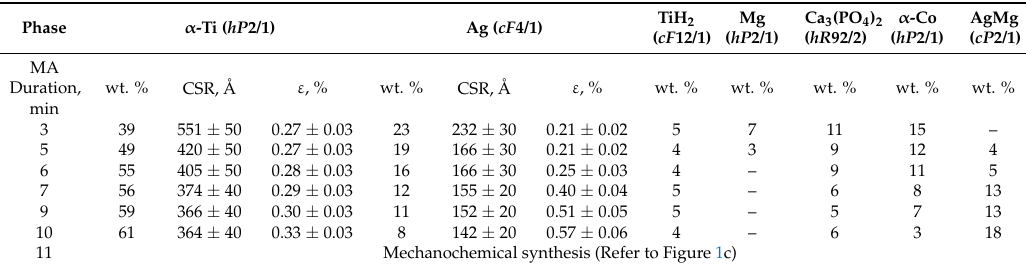
Table 1. Influence of the mechanically activated (MA) duration on the phase composition of the Ti–C–Co–Ca 3 (PO 4 ) 2 –Ag–Mg mixtures at X = 24%, the coherent scattering region (CSR) size, and the Ti and Ag lattice microstrain